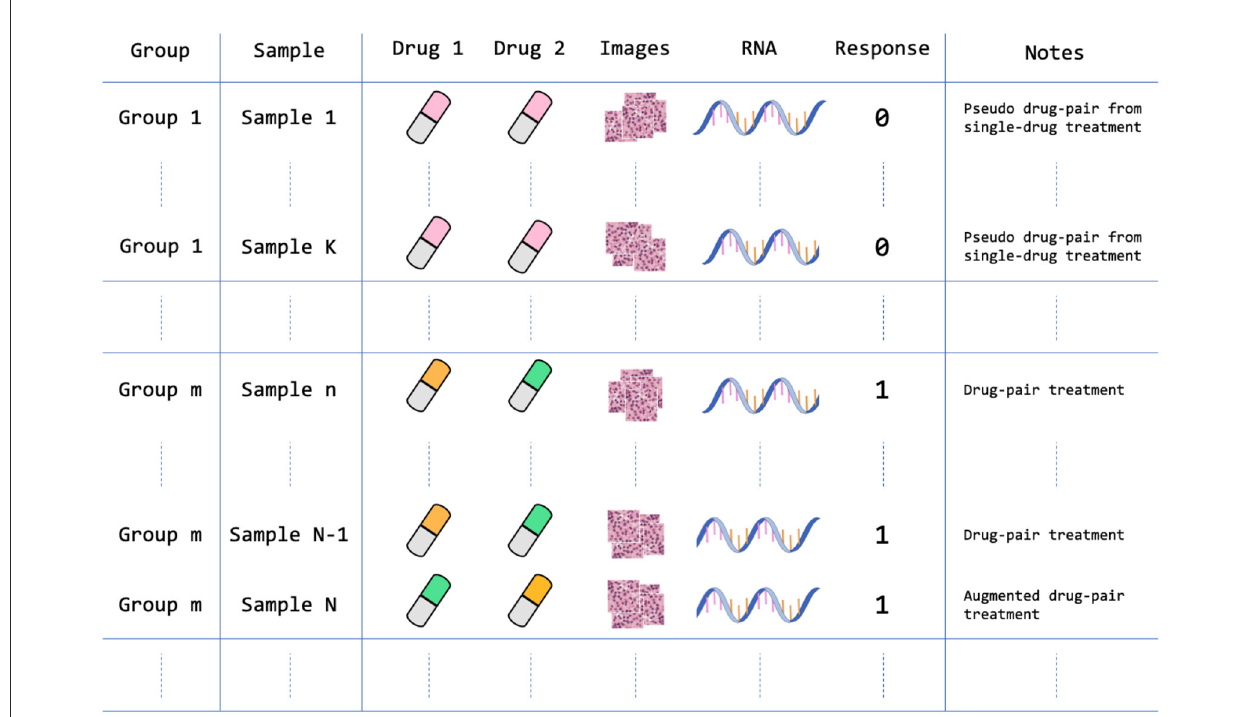
FIGURE4 Data arrangement of the PDX drug response dataset. The dataset contains 959 treatment groups after homogenizing and augmenting the drug experiments as described in Section 2.1.4. For example, Sample 1 is a single-drug treatment that is structured as a pseudo drug-pair treatment where Drug 1 and Drug 2 features are the same feature vectors; Sample N is an augmented version of Sample N-1, in which the positions of drug feature vectors are switched. Note that each sample contains multiple histology image tiles that were extracted from a large WSI.